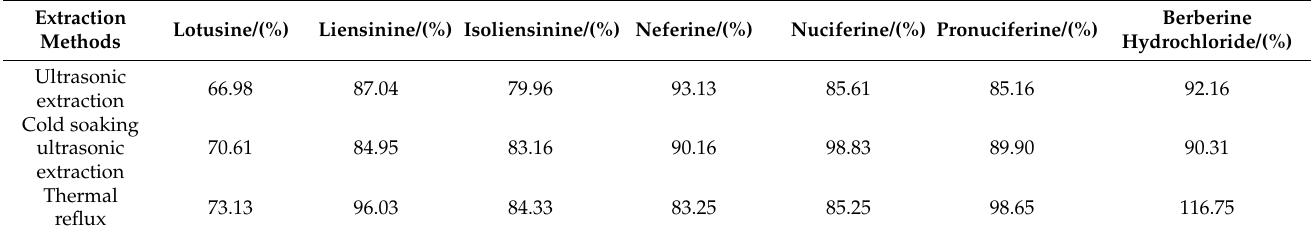
Table 2. Effects of different extraction methods on the extraction yields of seven kinds of alkaloids.